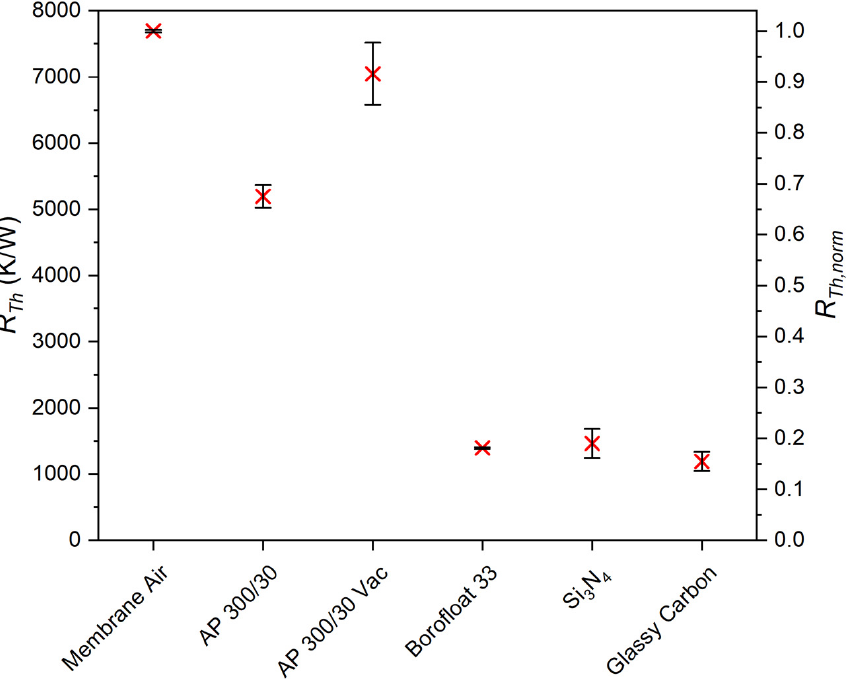
Figure 12. Left axis: Measurements of the thermal resistance R Th of the PowderMEMS-modified devices in comparison to a thin-film membrane surrounded by air and devices directly processed on Borofloat 33 glass. Right axis: Measurements normalized with respect to the measurement obtained for the thin-film membrane in air (“Membrane Air”). Table 2. Estimation of 𝜆 (cid:3017)(cid:3042)(cid:3045) for AP300/30 microstructures from normalized measurements ( n = 5) of . 𝑅 (cid:3021)(cid:3035) using the model presented in Equation (6)